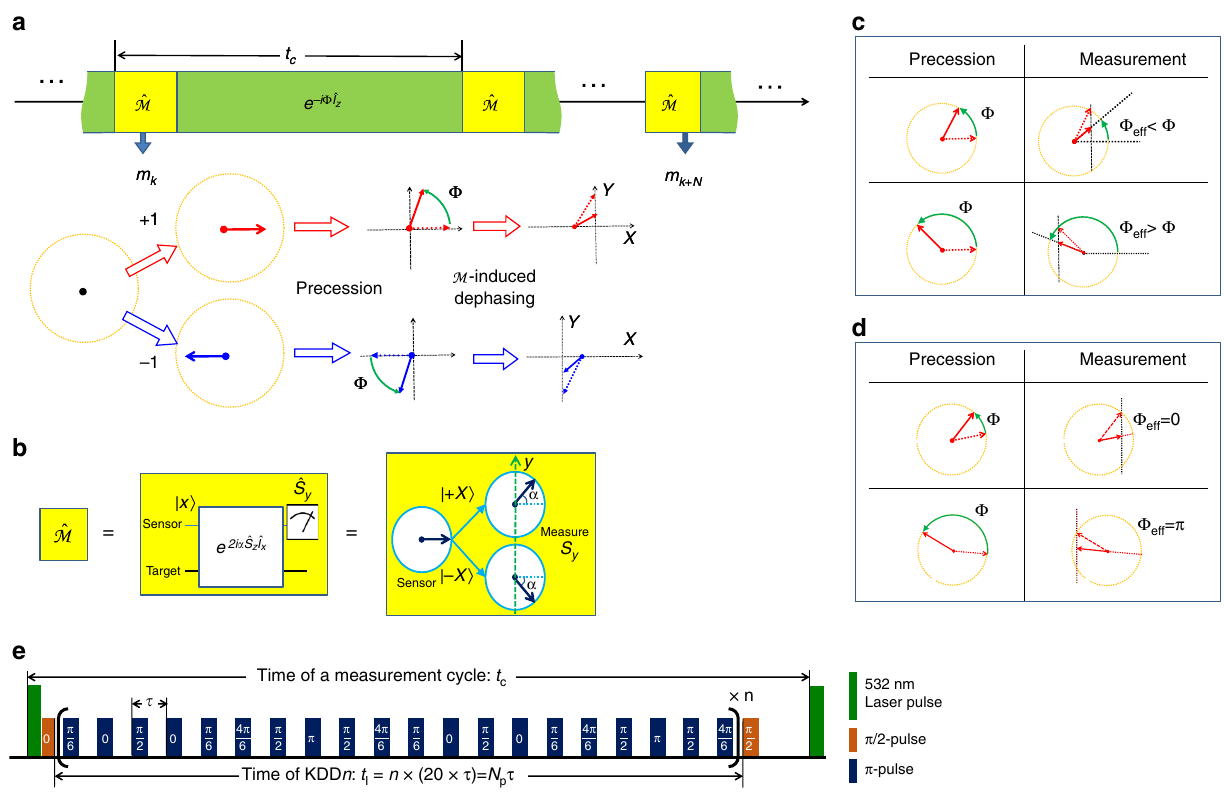
Fig. 1 Sequential weak measurement of a target spin via projective measurement of a sensor spin. a The target spin is partially polarized along X or − X depending on the k -th measurement result of the sensor spin, then undergoes free precession about the Z -axis. If the measurement result is discarded, the target spin experiences measurement-induced dephasing along the X -axis. The correlation between different measurements on the sensor, e.g., the k -th and the ( k + N )-th ones, re fl ects the spin dynamics. b The sensor-assisted weak measurement ( ^ M ) of the target spin. The sensor is initialized along the x - axis. By the control-phase gate, the sensor spin precesses about the z -axis by opposite angles for opposite target states ±X j i . A projective measurement on the sensor along the y -axis constitutes a weak measurement of the target spin. c, d Precession by an angle Φ (left column) and the measurement- induced dephasing (right column), shown as evolution from dotted arrows to solid ones. c The effective precession Φ is slowed down/sped up for Φ eff ¼ 0) or alternatively along opposite directions ( Φ ¼ π ). e In greater/less than π . d For Φ close to 0 or π , the spin is coherently trapped along an axis ( Φ eff eff 2 the experiment, a measurement cycle contains a 532 nm laser pulse (300 ns), a KDD n sequence ( n units of 20 equally separated π -pulses) sandwiched between two π /2-pulses and a waiting time. The numbers associated with the microwave pulses indicate the angle between the rotation axes and the y The control scheme for one measurement cycle is shown in Fig. 1e. The electron spin is optically pumped into the state 0 j i (cid:5) m ¼ 0 j i and then rotated to the x -axis state þ x j i by a π /2 pulse S about the y -axis. The y component of the electron spin is measured by applying a ( − π /2) pulse around the x -axis followed by a projective measurement along the z -axis via optical excitation and fl uorescence detection. The correlation function is extracted from the photon count statistics (see Methods and Supplementary Note 5). Between the initialization and readout of each cycle, we apply a sequence of N p equally spaced π -pulses, i.e., a dynamical decoupling (DD) control on the electron spin to ¼ modulate the hyper fi ne interaction for a total duration of t I N τ (with τ being the pulse interval). The Knill DD sequence p KDD n , which contains n units of 20 pulses applied along different axes (Fig. 1e) is chosen, to tolerate pulse errors in the many-pulse DD control 33 .